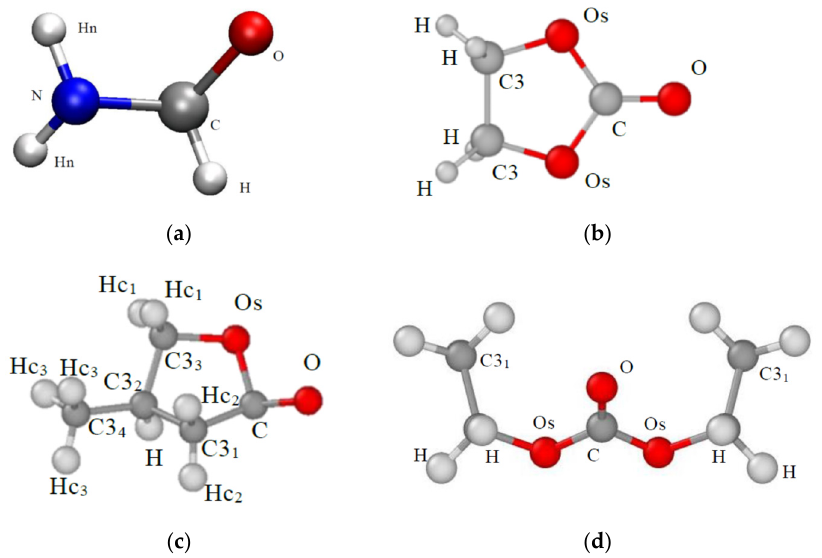
Figure 12. Molecular structure of formamide, the smallest one investigated here, compared with other larger molecules of solvents treated above. ( a ) Formamide (F); ( b ) ethylene carbonate (EC); ( c ) γ -valerolactone (GVL); ( d ) diethyl carbonate (DEC).